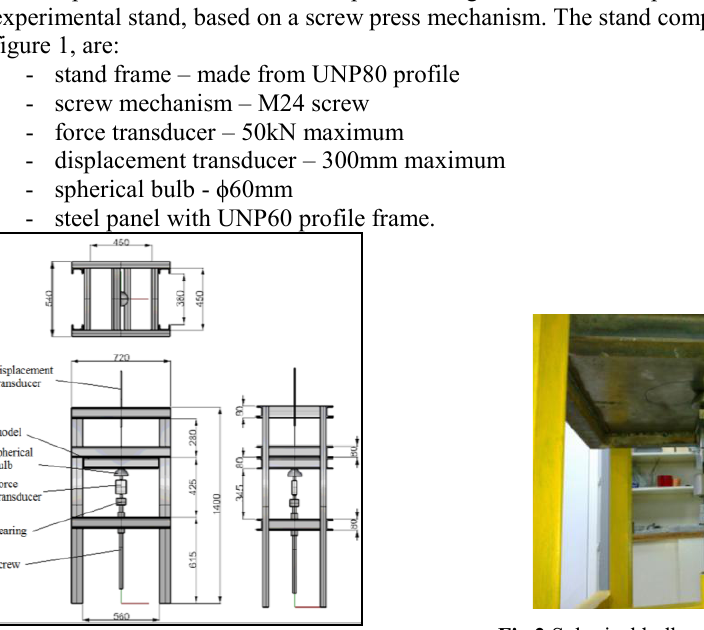
Fig.2 Spherical bulb acting on the panel